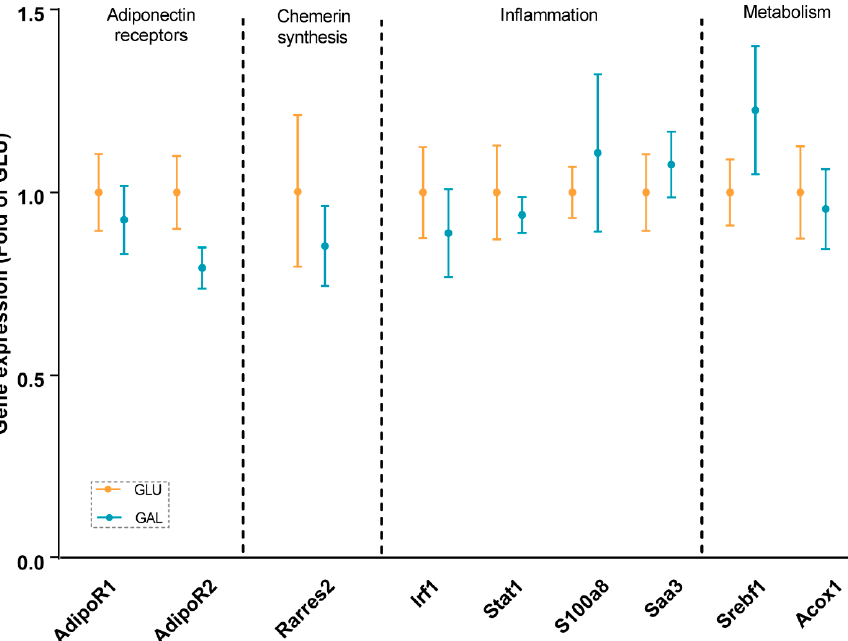
Figure 3. Gonadal white adipose tissue gene expression in GLU and GAL mice followed by nine weeks of a HFD. Irs1 : insulin receptor substrate 1; Irs2 : insulin receptor substrate 2; Tbc1d4 : TBC1 domain family member 4; Adipoq : adiponectin, C1Q, and collagen domain containing; Rarres2 : retinoic acid receptor responder 2; Pnpla2 : patatin-like phospholipase domain containing 2; Cpt1a : carnitine palmitoyltransferase I; Lpl : lipoprotein lipase; Mrc1 : mannose receptor C type 1; Saa3 : serum amyloid A 3; S100a8 : S100 calcium-binding protein A8; Mest : mesoderm-specific transcript homolog protein. Values are expressed as mean ± SEM (n = 10–14). * p < 0.05.